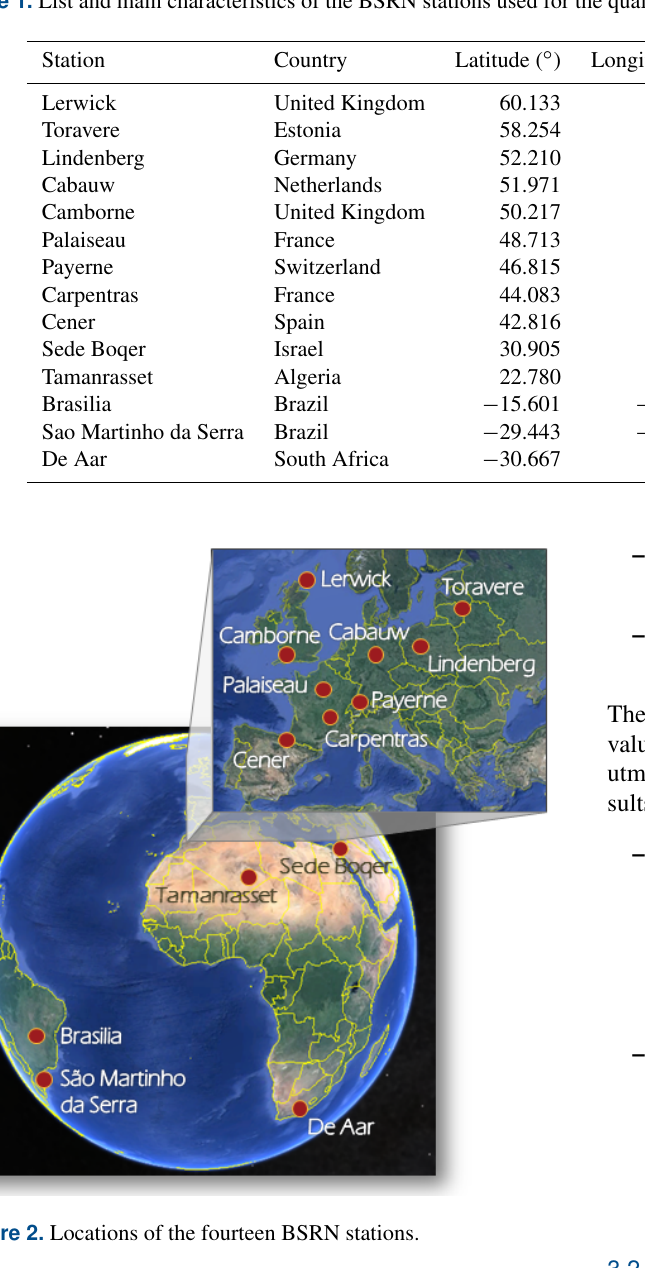
used for the quality assessment of the data, located in the MSG coverage. The last column of Table 1 gives the